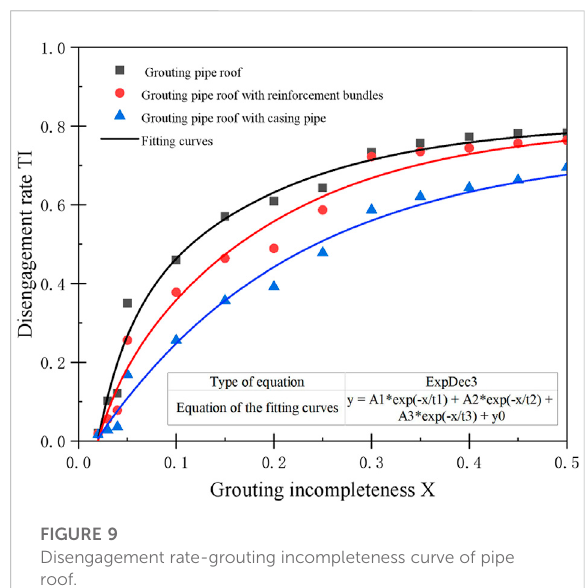
FIGURE 9 Disengagement rate-grouting incompleteness curve of pipe